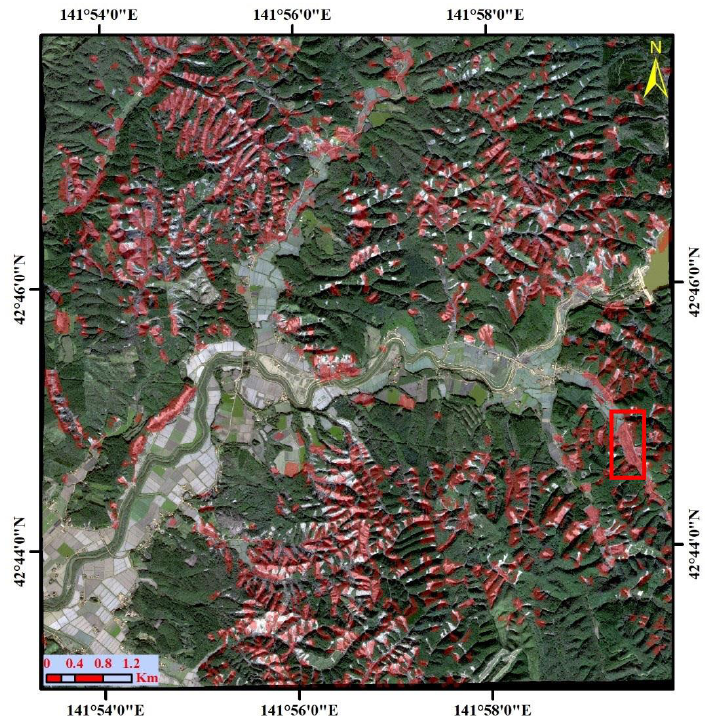
Figure 10. The landslide classification map using only the descending SAR intensity (case 2). The background is a GeoEye-1 image taken on 20 October 2018.